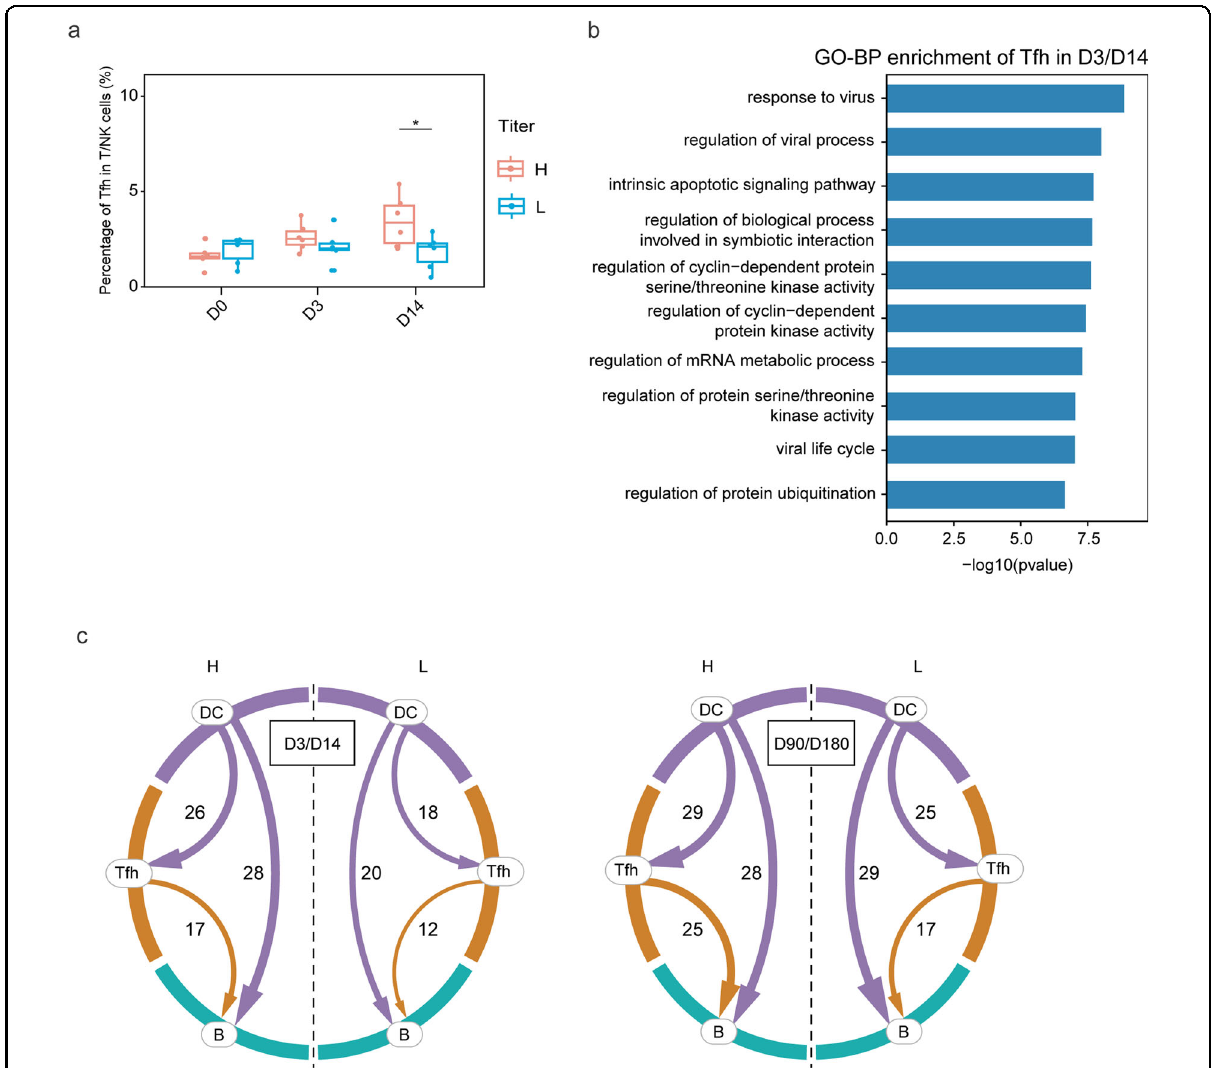
Fig. 6 Tfh numbers are elevated in the high-antibody group. a Variation of the proportion of Tfh cell subtypes in T/NK cells at D0, D3, and D14. b The enriched GO-BP terms of the upregulated genes of Tfh in high-antibody-titer group at D3/D14 post-vaccination. P value was derived by Benjamini & Hochberg test. c The Circos plots showed the cell − cell interaction among cDCs, Tfh cells and B cells at D3/D14 and D90/D180. The width of each line represents the number of the protein − protein interactions involved in cell − cell